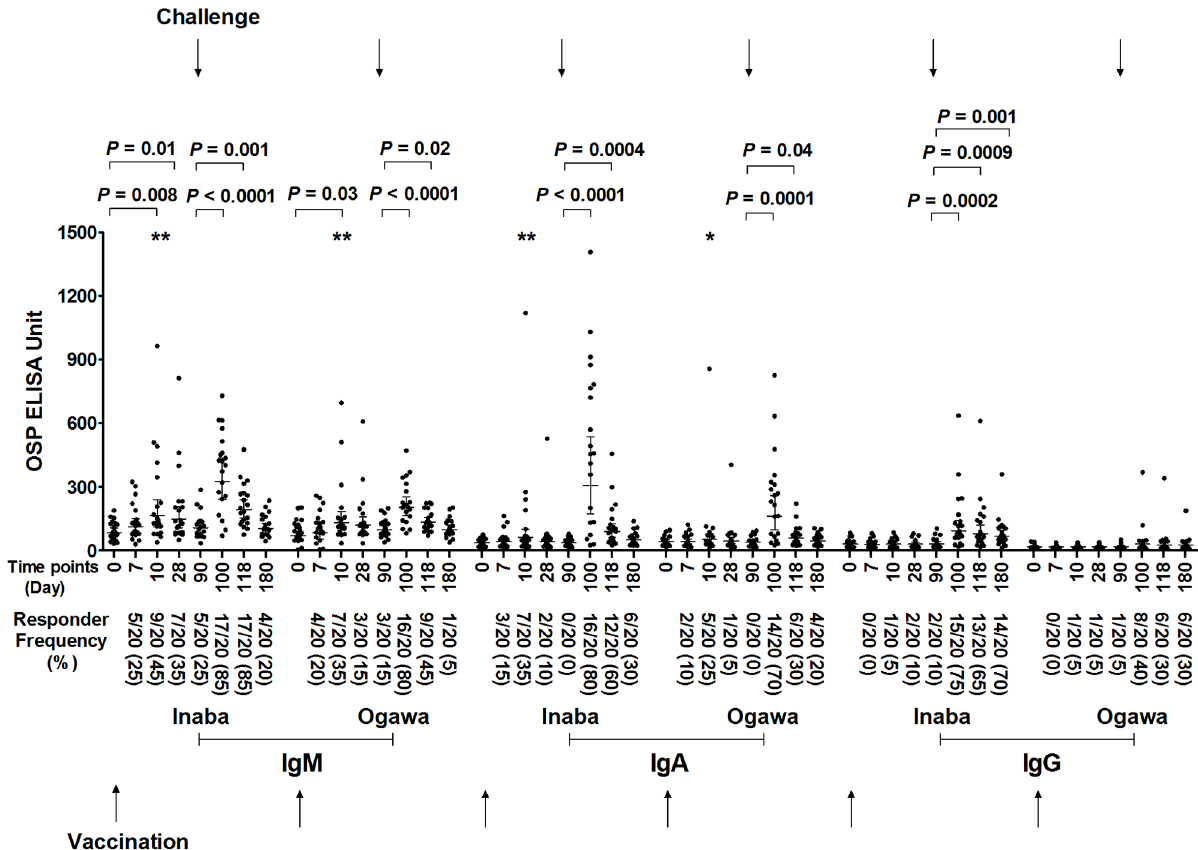
Fig 3. Serum antibody responses against OSP in vaccinees of day 90 challenged group. Serum IgM, IgA and IgG responses targeting V . cholerae O1 Inaba or Ogawa OSP in recipients (n = 20) of oral cholera vaccine CVD 103-HgR who were then experimentally challenged with wild type V . cholerae O1 Inaba N16961 90 days after vaccination (denoted by top arrows). Day 0 is pre-vaccination and other dates are timed from vaccination. X axis indicates the time points of samples, while Y-axis denotes OSP-specific antibody responses. Each single dot indicates an individual OSP antibody value, horizontal bars indicate the geometric mean (GM), and error bars indicate 95% confidence intervals. P values represent differences of the mean between groups. Asterisks represent significant differences of responder frequency in Fisher’s exact test ( (cid:3)(cid:3)(cid:3) P (cid:20) 0.001, (cid:3)(cid:3) P (cid:20) 0.01). We defined a responder as having a (cid:21) 1.5-fold increase in anti-OSP units compared to pre-vaccination value. Responder frequency is represented in parenthesis on x- axis.